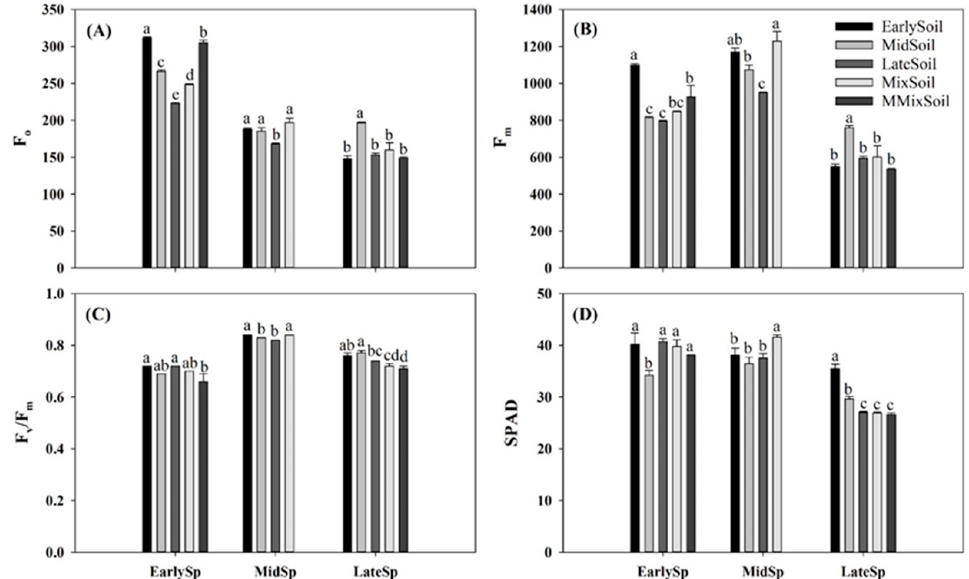
Figure 3. Effects of soil feedback on F o ( A ), F m ( B ), F v /F m ( C ), and SPAD values ( D ) in early-, mid-, and late-successional species. Error bars are standard errors ( n = 4). Different letters above the bars indicate significant differences at p < 0.05.